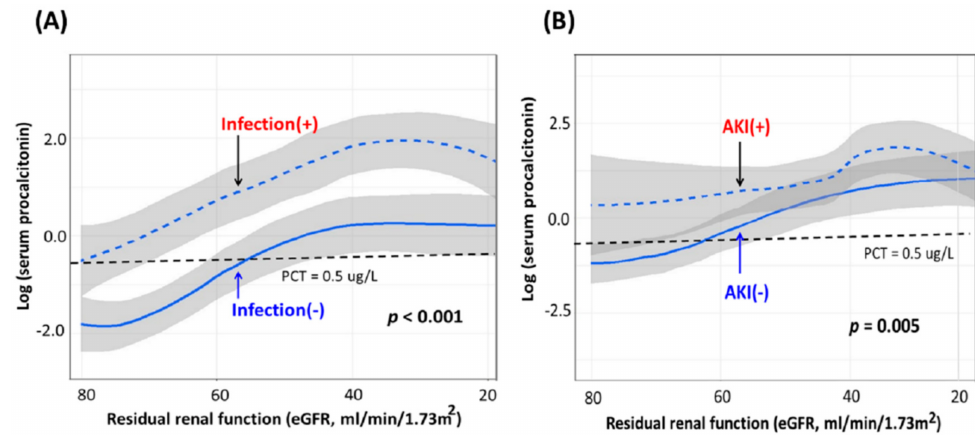
Figure 2. Serum PCT levels between groups stratified by ( A ) infection and ( B ) AKI. Note: The figures were modified from the work of Huang et al. [25]. Abbreviations: AKI, acute kidney injury; eGFR, estimated glomerular filtration rate; PCT,